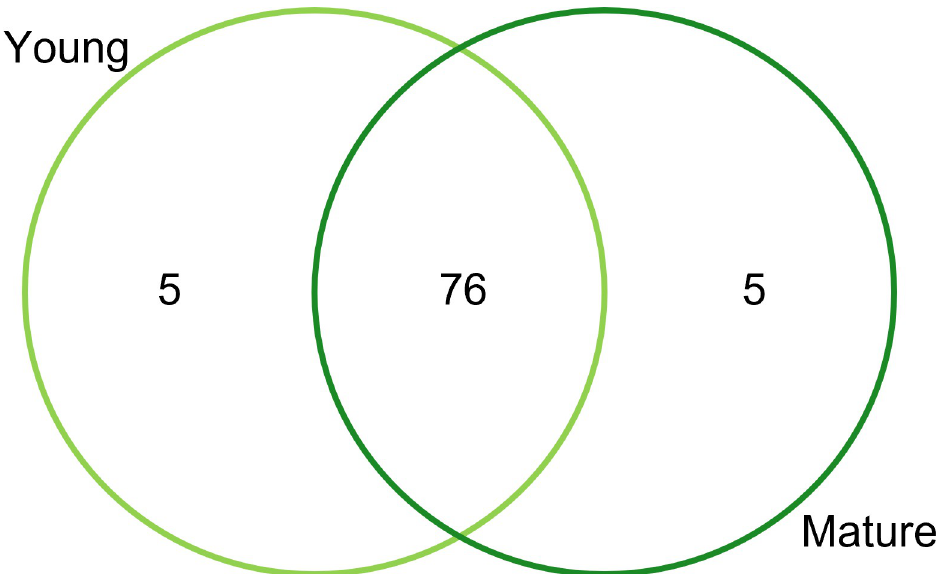
Fig 2. Venn diagram representing the number of overall identified metabolite features shared between or unique to young and mature leaves of M . speciosa .